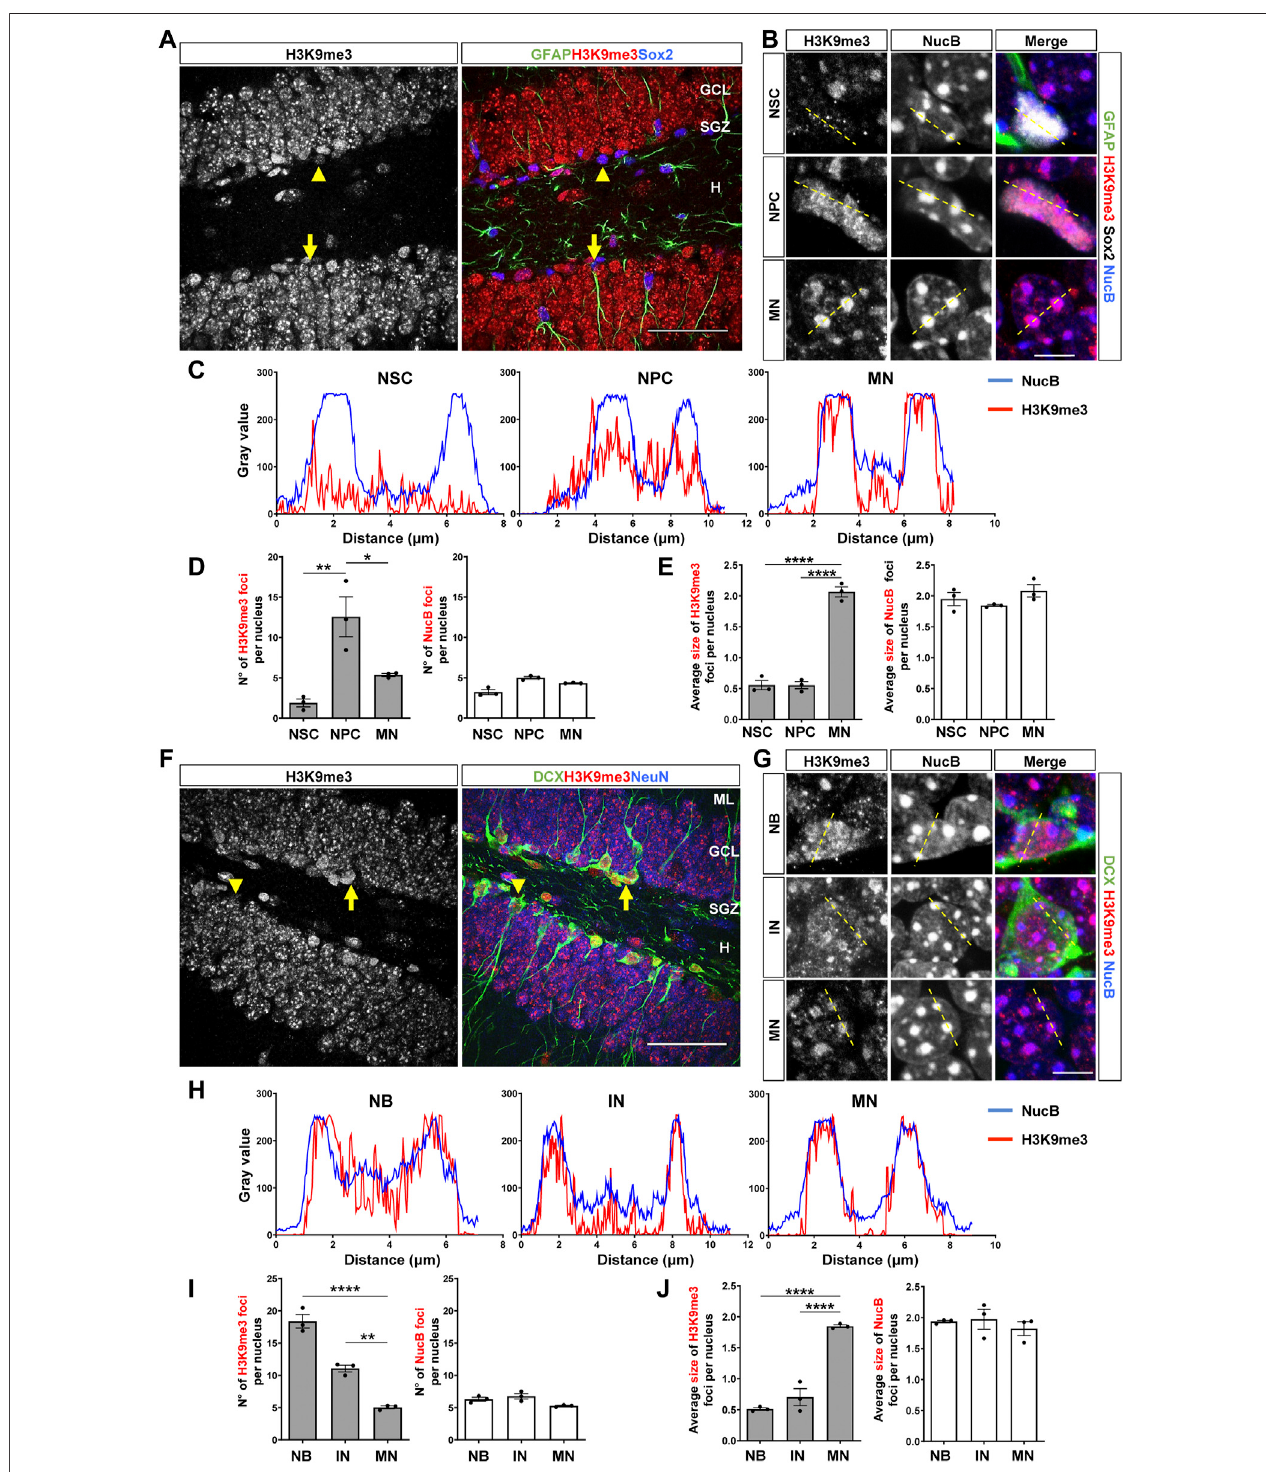
FIGURE 1 | Nuclear H3K9me3 staining and distribution during the stages of neurogenesis in the adult mouse hippocampus. (A) Immunostaining of H3K9me3, GFAPand Sox2intheDGof2-month-oldmouse. Thearrow indicatesaNSC(GFAP+Sox2+),thearrowheadindicatesanNPC(GFAP-Sox2+).Scalebar50 µm.Higher magni fi cations are shown in Supplementary Figure S1A . (B) Digital zoom of nuclei from NSC (top), NPC (middle) and mature neuron (MN, bottom). GFAP (green), H3K9me3 (red), Sox2 (white) NucB (blue). Dotted lines indicate the line scans analyzed in C. Scale bar 10 µm. (C) Fluorescence intensity of H3K9me3 (red) and NucB(blue)inlinescansdrawnacrosschromocentersinnucleifromNSC,NPCandMNusingasingleconfocalsection. (D) AveragenumberofH3K9me3andNucBfoci